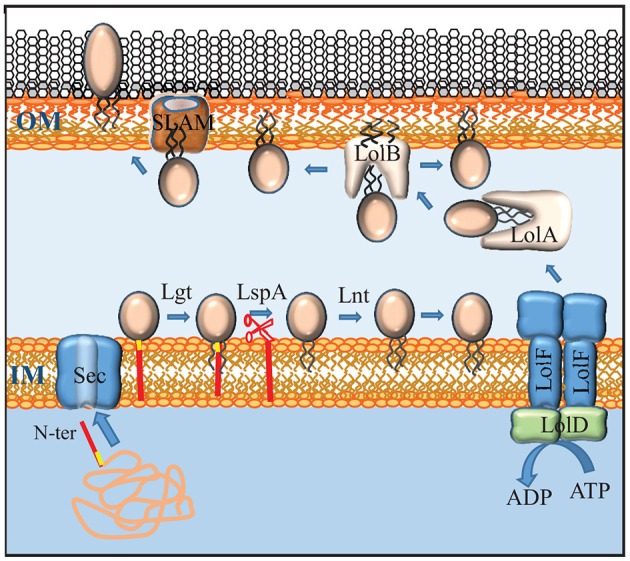
Maturation, transport and secretion of lipoproteins. Lipoproteins contain a lipobox (yellow) at the C terminus of their signal sequence (red). After transport across the inner membrane (IM) by the Sec system, the lipoprotein precursor is modified by the addition of a diacylglyceryl moiety to the sulfhydryl group of the cysteine in the lipobox by Lgt, followed by cleavage of the signal sequence by LspA, and the addition of a third, amide-linked fatty acyl chain by Lnt. Lipoproteins that don't contain an IM-retention signal (also called Lol-avoidence motif) are expelled from the IM by an ABC transporter that, in Neisseria, consists of a dimer of LolF (instead of the LolCE heterodimer found in E. coli) and a dimer of LolD. The chaperone LolA shields the lipid moiety of the lipoprotein during periplasmic transit and shuttles it to the receptor LolB that inserts it into the inner leaflet of the OM. Some lipoproteins are translocated to the outer face of the OM via a mechanism that requires a SLAM protein. Whether SLAM forms the actual translocation channel itself is not known.